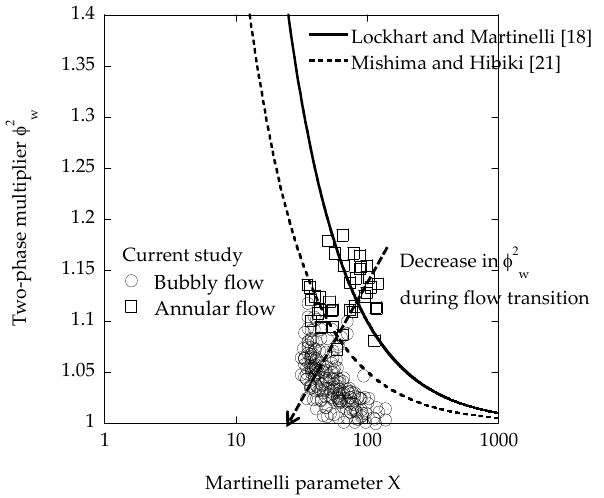
Figure 9. Two ‐ phase multiplier for all experimental data based on annular and bubbly flow. Figure 9. Two-phase multiplier for all experimental data based on annular and bubbly